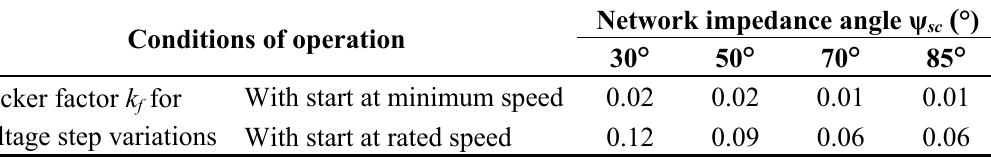
Table 5. Values of the flicker factor k